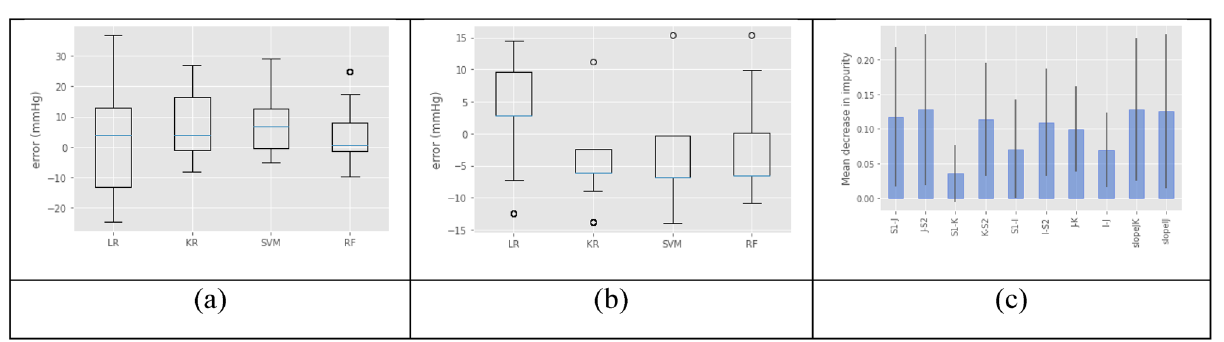
Figure 7. Boxplots: ( a ) Four algorithms evaluated in D 1 , ( b ) Four algorithms evaluated in D 2 , and ( c ) Feature importance based on